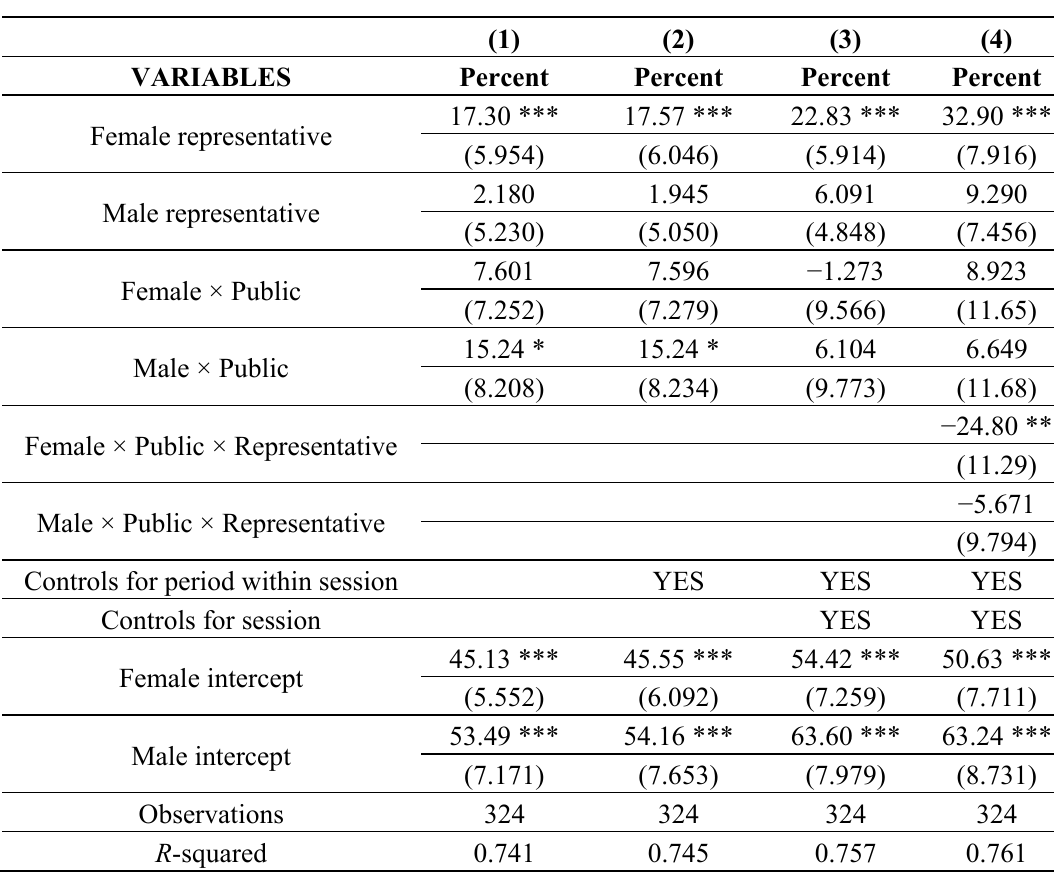
Table 2. Regression results for outcome “Share of endowment contributed to public good”. Clustering on the individual. Robust standard errors in parentheses. *** p < 0.01; ** p < 0.05; * p <